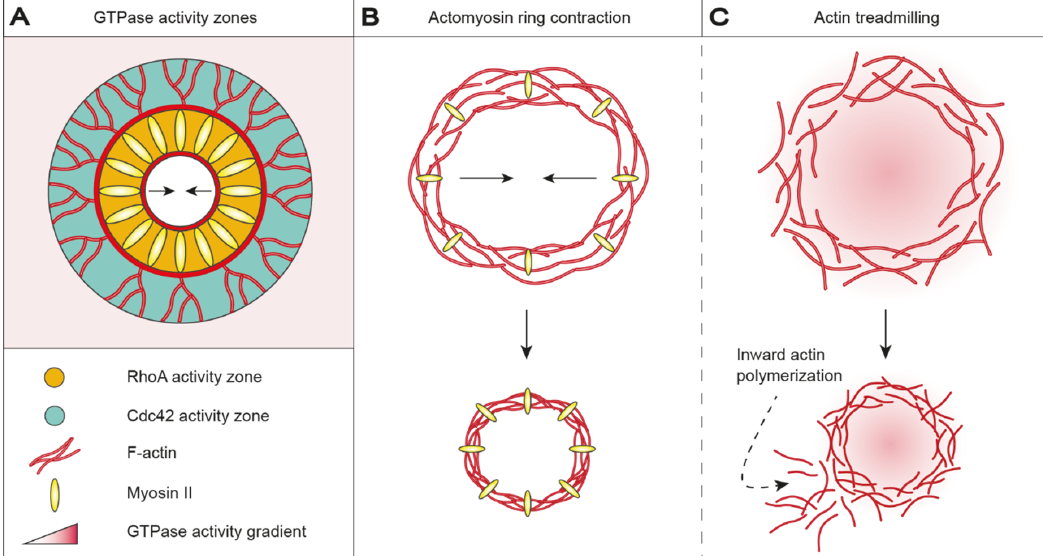
Figure 2. Wound healing in Xenopus oocytes is accomplished by contraction of an actomyosin ring or actin treadmilling. ( A ) Actomyosin ring positioning, assembly and contraction are orchestrated by demarcated GTPase activity zones. Injury ‐ triggered Ca 2+ influx recruits and activates RhoA (orange) and Cdc42 (green), which accumulates in mutually exclusive, concentric activity zones around the wound. RhoA and Cdc42 co ‐ localize with myosin II and actin, respectively. RhoA stimulates polymerization of stable, unbranched actin filaments in the inner zone, whereas Cdc42 stimulates polymerization of dynamic, branched actin filaments in the outer zone. ( B ) In detail, RhoA controls actomyosin contractibility by influencing the activity of MLCK and ROCK, which in turn regulates myosin II light chain phosphorylation levels. Accordingly, wound closure is promoted by actomyosin ‐ based ring contraction. ( C ) Alternatively, contraction ‐ independent wound closure can be mediated through actin treadmilling. Here, a directional GTPase activity gradient from the leading edge to the trailing edge of the wound results in inward actin polymerization, which constricts and eventually seals the wound; however, actin treadmilling results in less organized and discontinuous wound closure. Ca 2+ : calcium ions; Cdc42: cell division control protein 42 homolog; MLCK: myosin light ‐ chain kinase; RhoA: Ras homolog family member A; ROCK: Rho ‐ associated kinase.